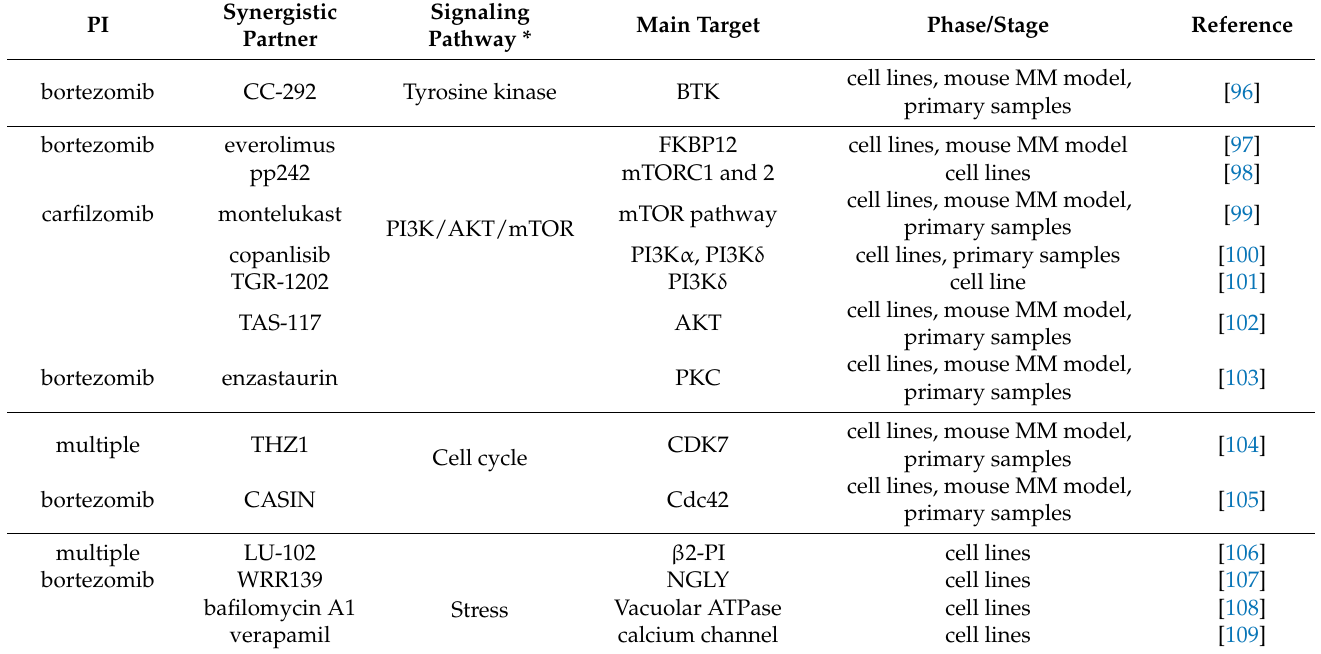
Table 2. Emerging drug combinations with proteasome inhibitors for the treatment of multiple